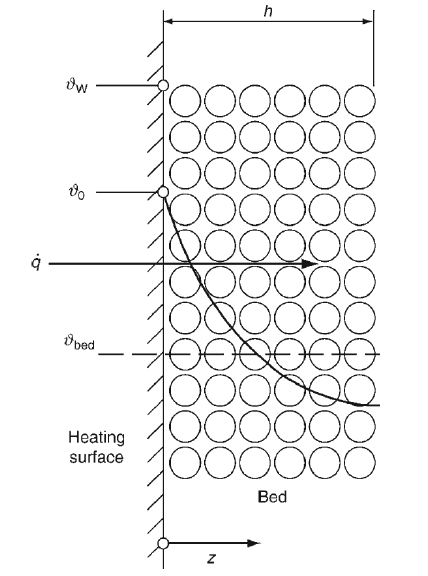
Fig. 1. Scheme of heat transfer from a wall to an adjoining bed of particles